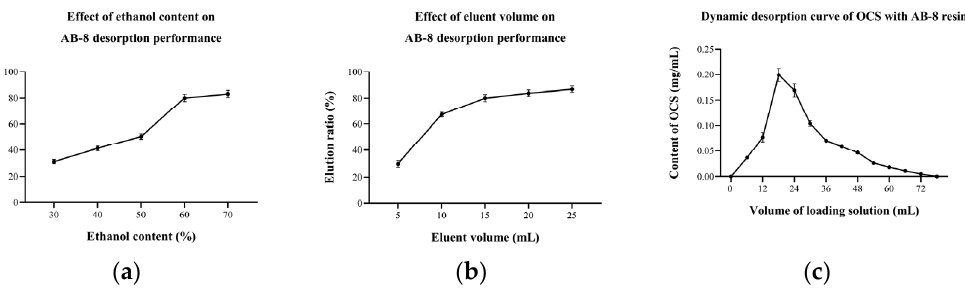
Figure 6. Effect of ( a ) eluent concentration and ( b ) eluent volume on AB-8 desorption performance; and ( c ) dynamic desorption curve of OCS with AB-8 resin.